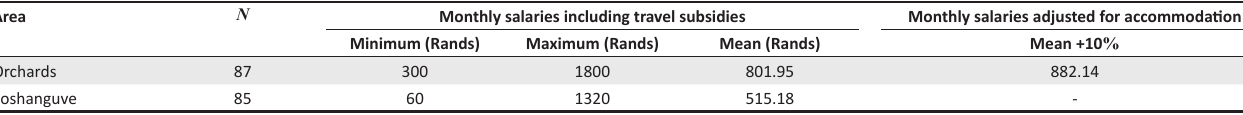
TABLE 8: Monthly average salaries adjusted for transport in Orchards and Soshanguve in 2007. Area N Monthly salaries including travel subsidies Monthly salaries adjusted for